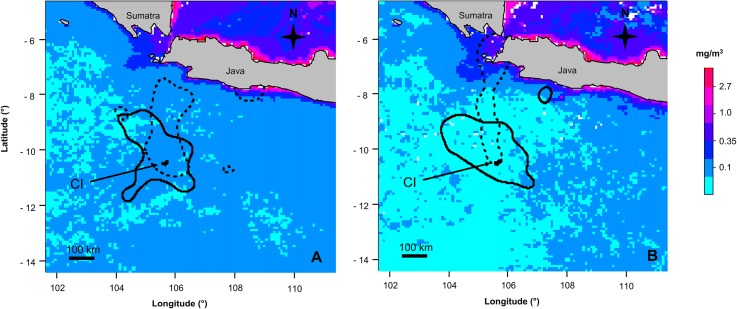
Core foraging areas and chlorophyll a concentrations during the brooding period.Core foraging area (50% Kernel density estimation) of Christmas Island Frigatebirds and chlorophyll a concentrations during the brooding periods of (a) 2009 and (b) 2010 (females = solid line, males = dashed line; chlorophyll a concentration for May and June combined, logarithmic scale).